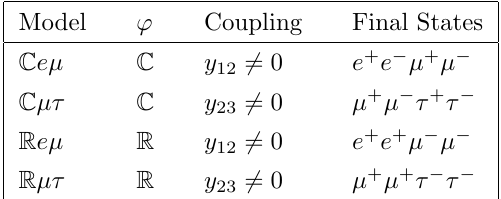
Table 1 . The four pure o(cid:11)-diagonal, single-coupling models considered in this section. In the cases with real ’ , the opposite-sign cases appear with equal frequency to the more striking same-sign cases listed. We expect y 13 6 = 0 models to have very similar exotic Higgs decay phenomenology to the analogous y 23 6 = 0